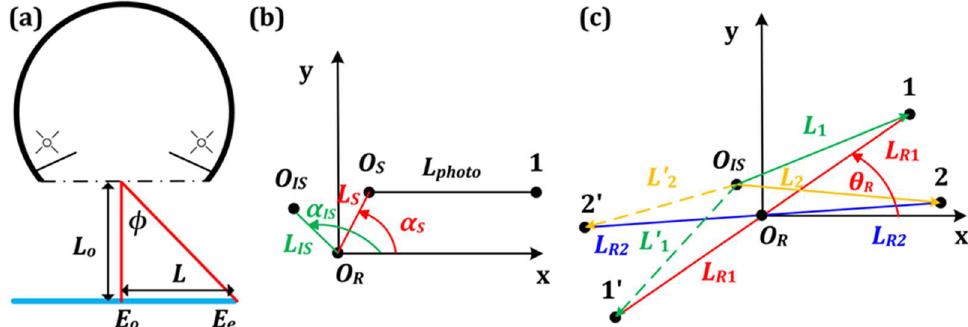
Figure 7. ( a ) Schematics illustrating the integrating sphere; ( b ) Schematics illustrating the eccentric feature of the three centers; ( c ) Schematics illustrating how to use the central-symmetry method in calibration.